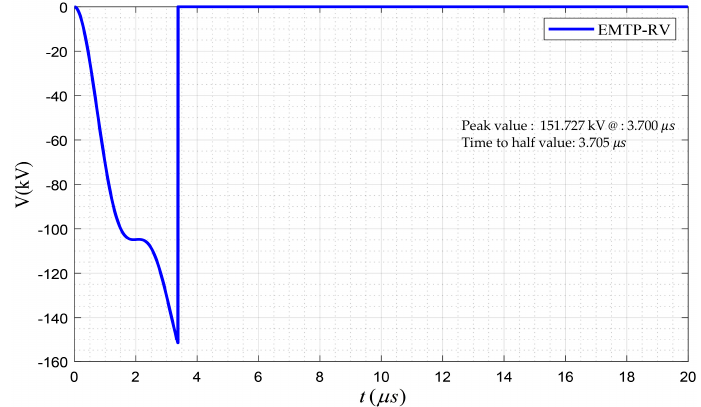
Figure 18. Applied impulse 125 kV in the presence of 500 μH filtered spark gap, EMTP-RV model.